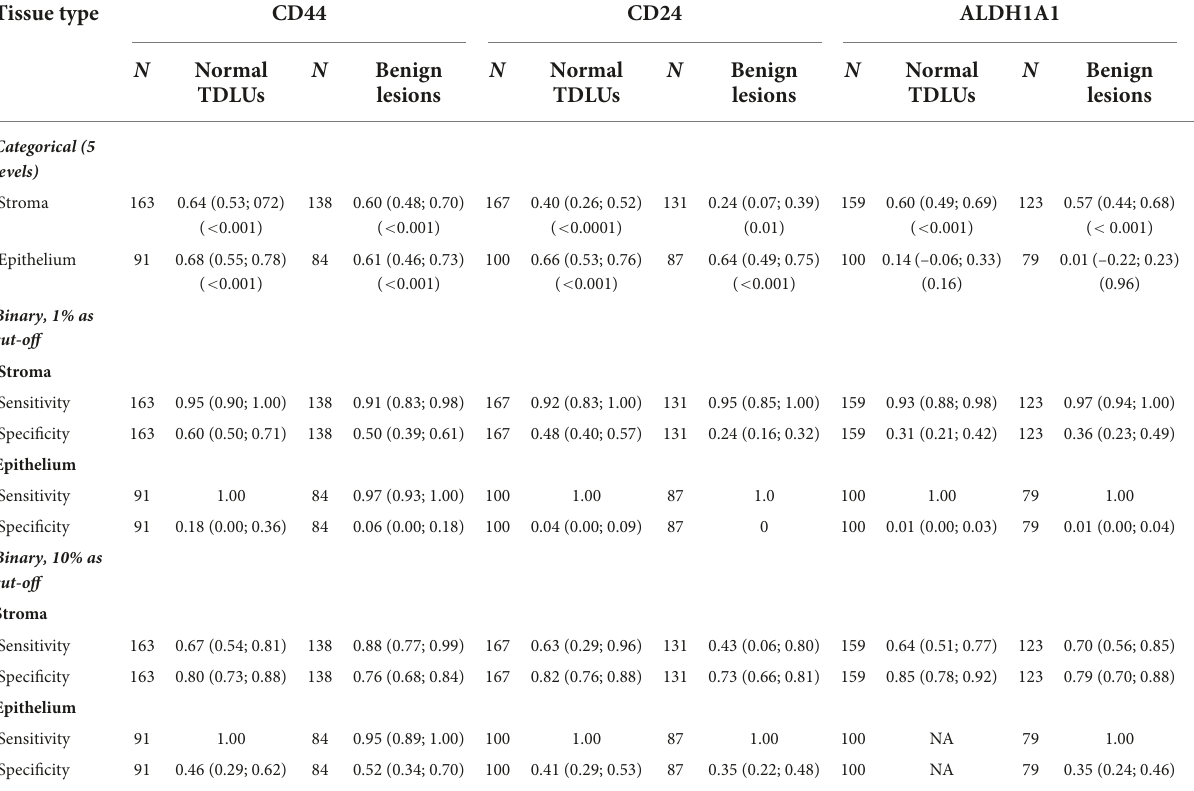
TABLE 4 Correlation of stem cell marker expression from pathologist and Definiens assessments [Spearman rank correlation coefficient (95% CI and p -value) for categorical; sensitivity (95% CI) and specificity (95% CI) for binary variables]. Tissue